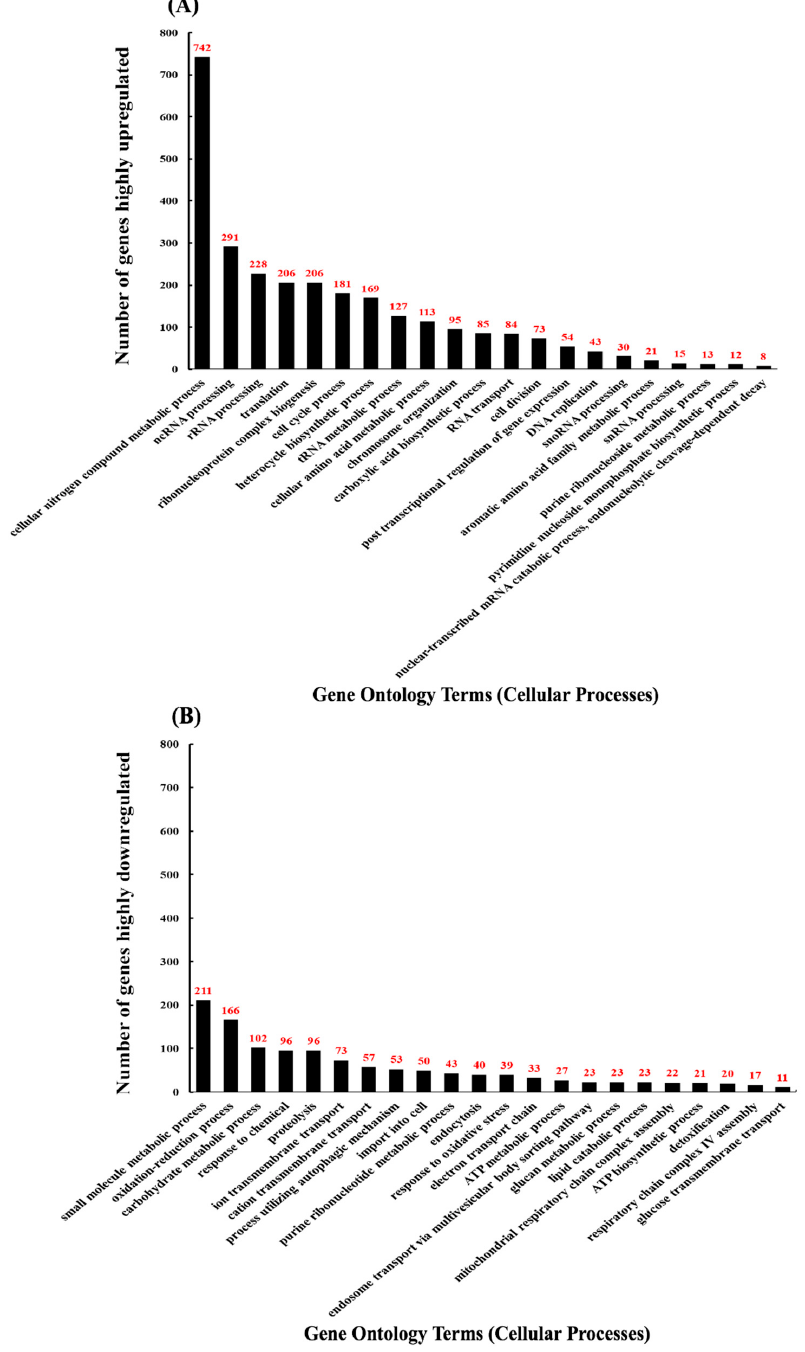
Figure 2. Di ff erentially expressed genes with CdSe / ZnS-QDs (quantum dots). GO (gene ontology) terms corresponding to each di ff erentially expressed gene’s biological process. Out of 4478 genes with a q -value below 0.05, 2839 genes with a fold change greater than or equal to 1.5 were incorporated. ( A ) The quantification of upregulated genes associated with their specific GO terms. Of the 2839 statistically di ff erent genes, 1560 were found to be upregulated. ( B ) The quantification of downregulated genes associated with their specific GO terms. Of the 2839 genes, 1279 were found to be